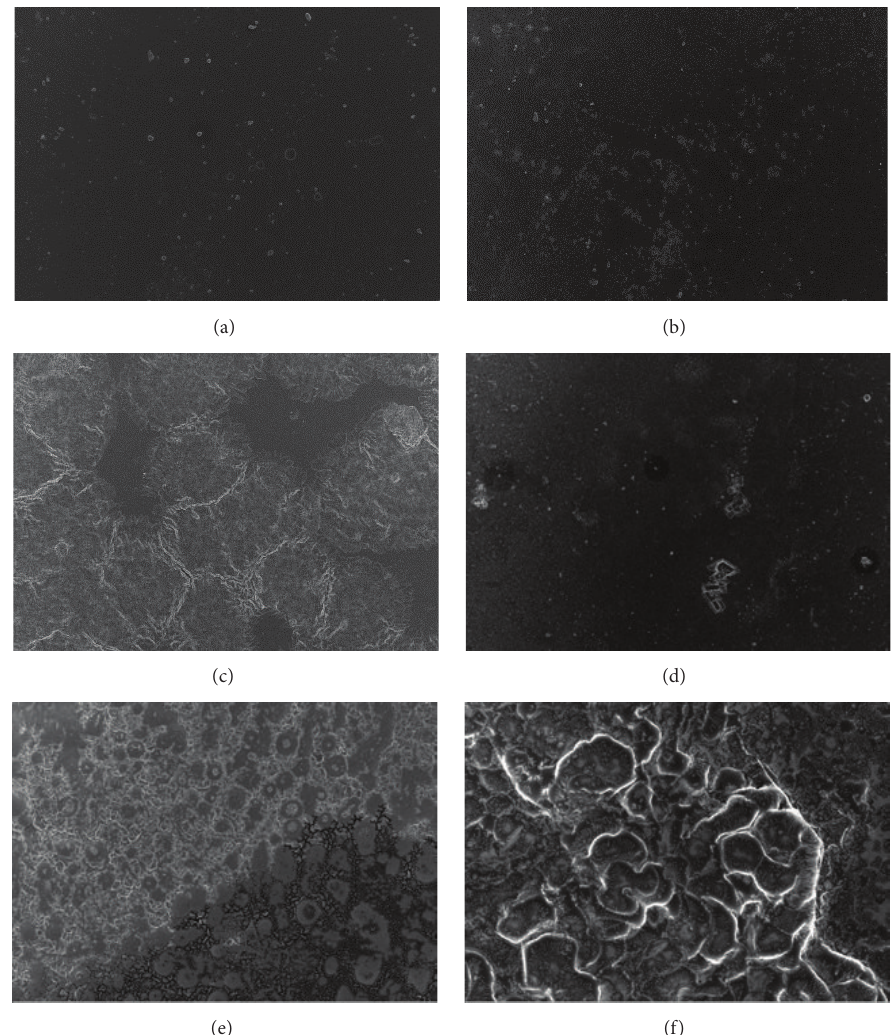
Figure 3: Scanning electron microscopy of the films at 1000x. (a) 0.25% w/w trehalose pH 4, (b) 0.25% w/w trehalose pH 8, (c) 0.75% w/w trehalose pH 4, (d) 0.75% w/w trehalose pH 8, (e) 1%w/w Tween 20 pH 4, and (f) 1%w/w Tween 20 pH